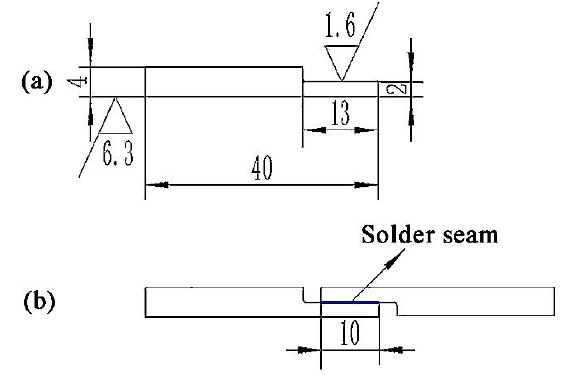
Figure 1. Details of Cu substrate sample ( a ) and solder joint ( b ). (Unit: mm)